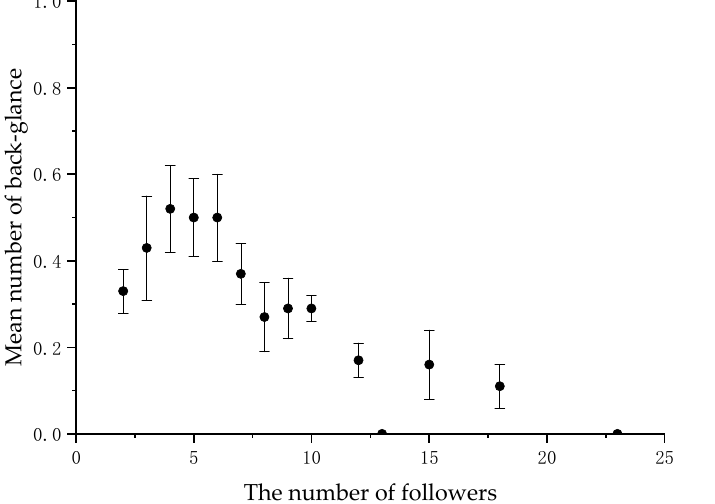
Figure 1. Mean frequency of the initiator’s back-glance per collective movement according to the number of followers .